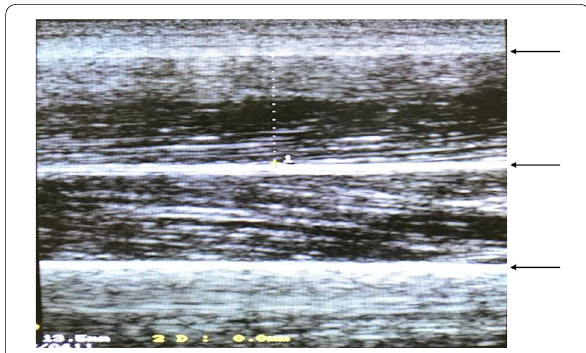
Fig. 2 Ultrasound of rectus femoris muscle. Ultrasound images of the muscular layers were obtained, and the muscle thickness of the rectus femoris was measured by drawing a perpendicular line from the border lines of the rectus femoris to the border lines of the vastus intermedius. On the screen of the US (ultrasonography) device, muscle thickness was calculated by setting the cursor to two points from the border lines of the rectus femoris to the border lines of vastus intermedius. Top arrow: rectus femoris muscle; middle arrow: vastus intermedius muscle; bottom arrow: femur